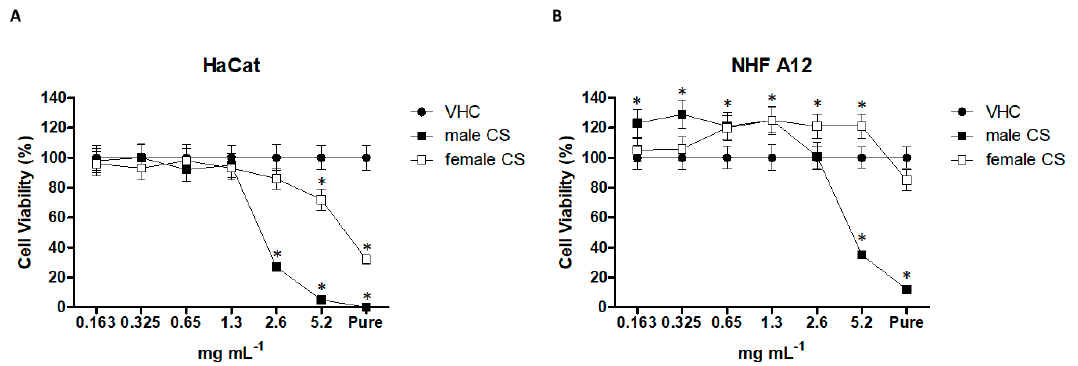
Figure 4. ( A ) HaCaT and ( B ) NHF A12 viability after treatment with different concentrations of EOs. Both cell lines were treated with different concentrations of male CS and female CS EOs, and cell viability was evaluated after 24 h post-treatment. * p < 0.05 vs vehicle.